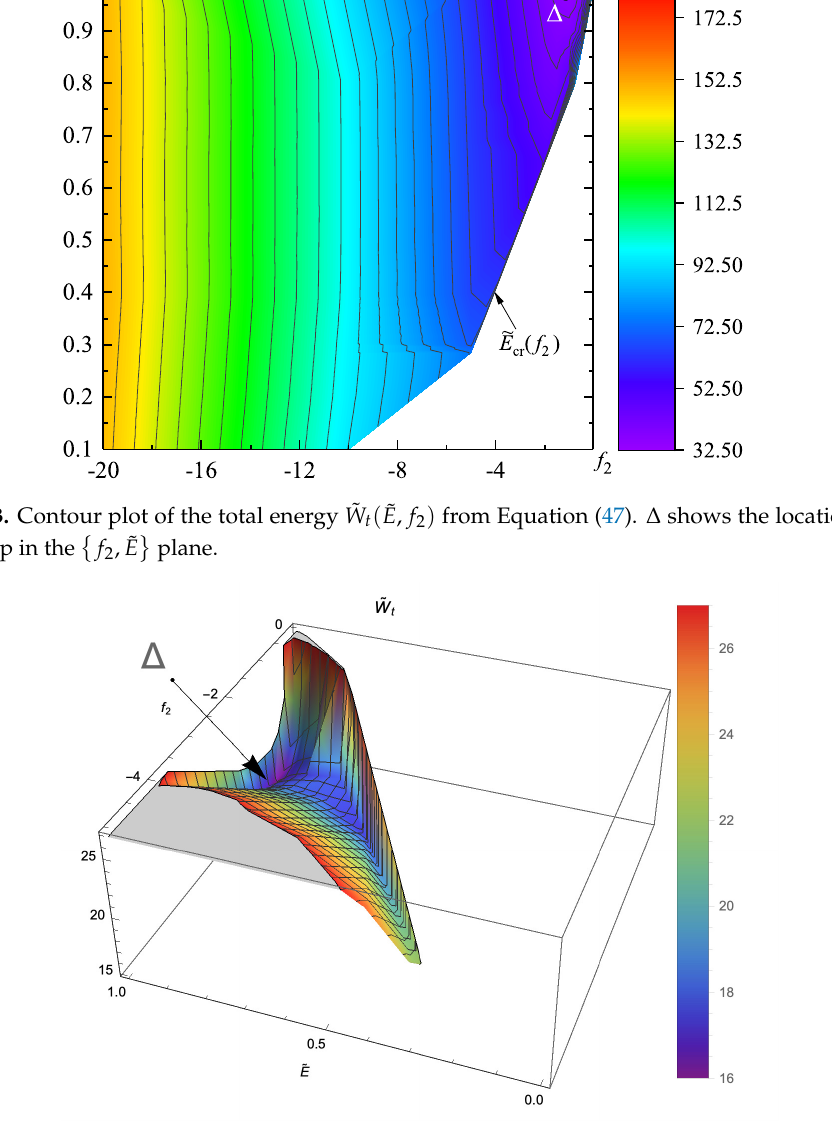
Figure 4. Three-dimensional plot for the dependence of the total energy (47) on the parameters f 2 and ˜ E in the vicinity of the mass gap ∆